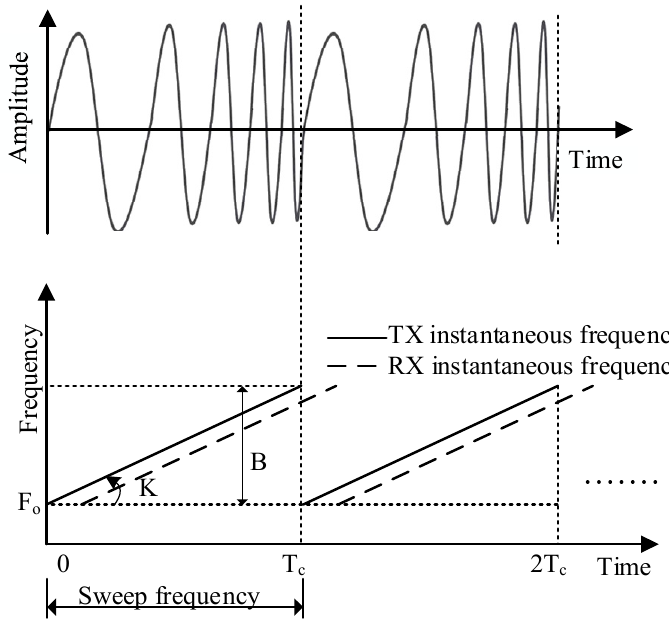
Figure 2 . Detection of chest wall displacement [6–11]. Figure 2. Detection of chest wall displacement